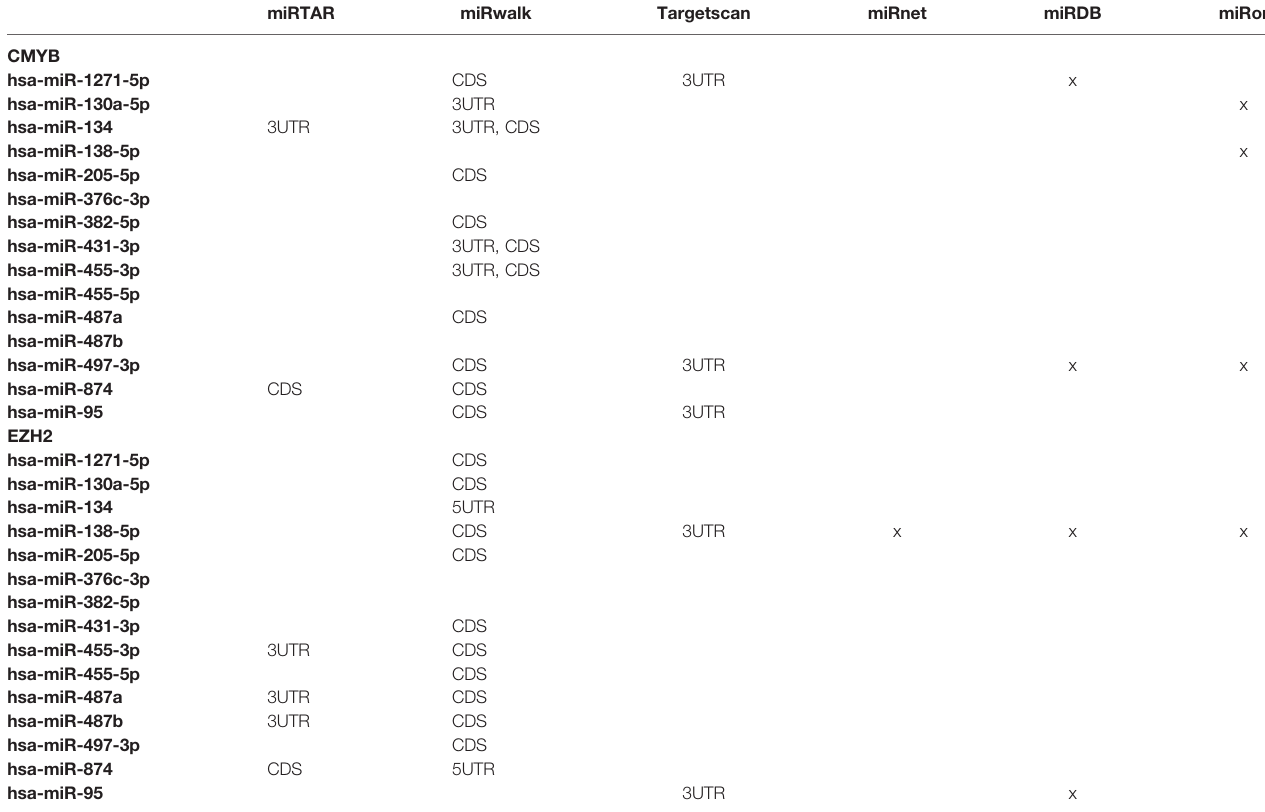
TABLE 2 | Prediction analysis of miRNA-target interaction from MYB and EZH2